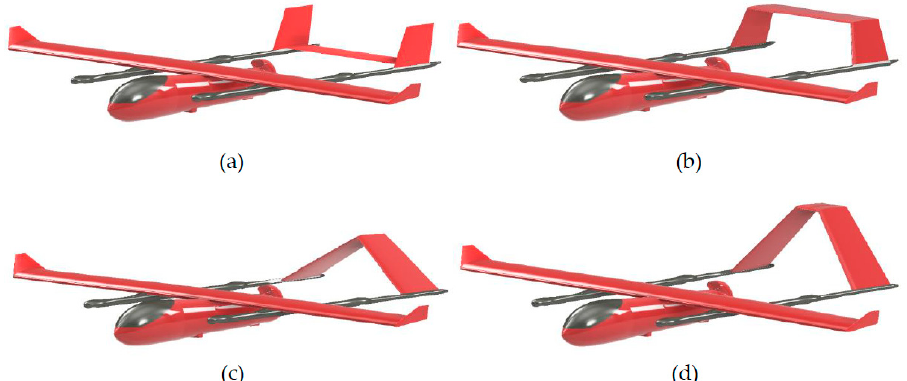
Figure 6. Three-dimensional geometry of the VTOL-Plane, with variations in empennage configura- tions: ( a ) U-shaped boom, ( b ) inverted U-shaped boom, ( c ) inverted V-tail boom, ( d ) semi-inverted V-tail boom.